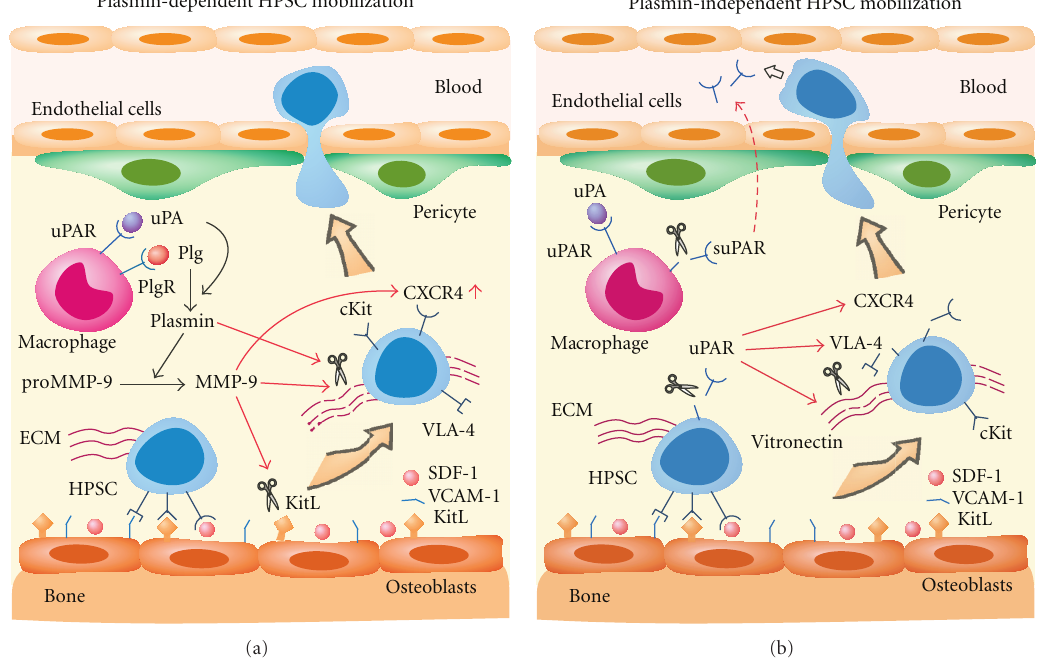
Figure 1: Plasmin-dependent and -independent mechanisms for HPSC mobilization from the BM to circulation. (a) Plasmin-mediated proteolysis induces HPSC mobilization. uPA converts Plg into protease-active plasmin that activates pro-MMP-9. Active MMP-9 cleaves KitL and upregulates CXCR4, and MMP-9 and plasmin degrade ECM, both of which release HPSC from the BM, leading to HPSC egress to circulation. (b) Plasmin-independent proteolysis and chemotaxis induce HPSC mobilization. uPAR is cleaved to chemotactic suPAR that drives HPSC migration to circulation. Cleavage of membrane uPAR also directly disrupts the interaction between uPAR and VLA-4, degrades vitronectin, and desensitizes the CXCR4 signal, which leads to HPSC mobilization.